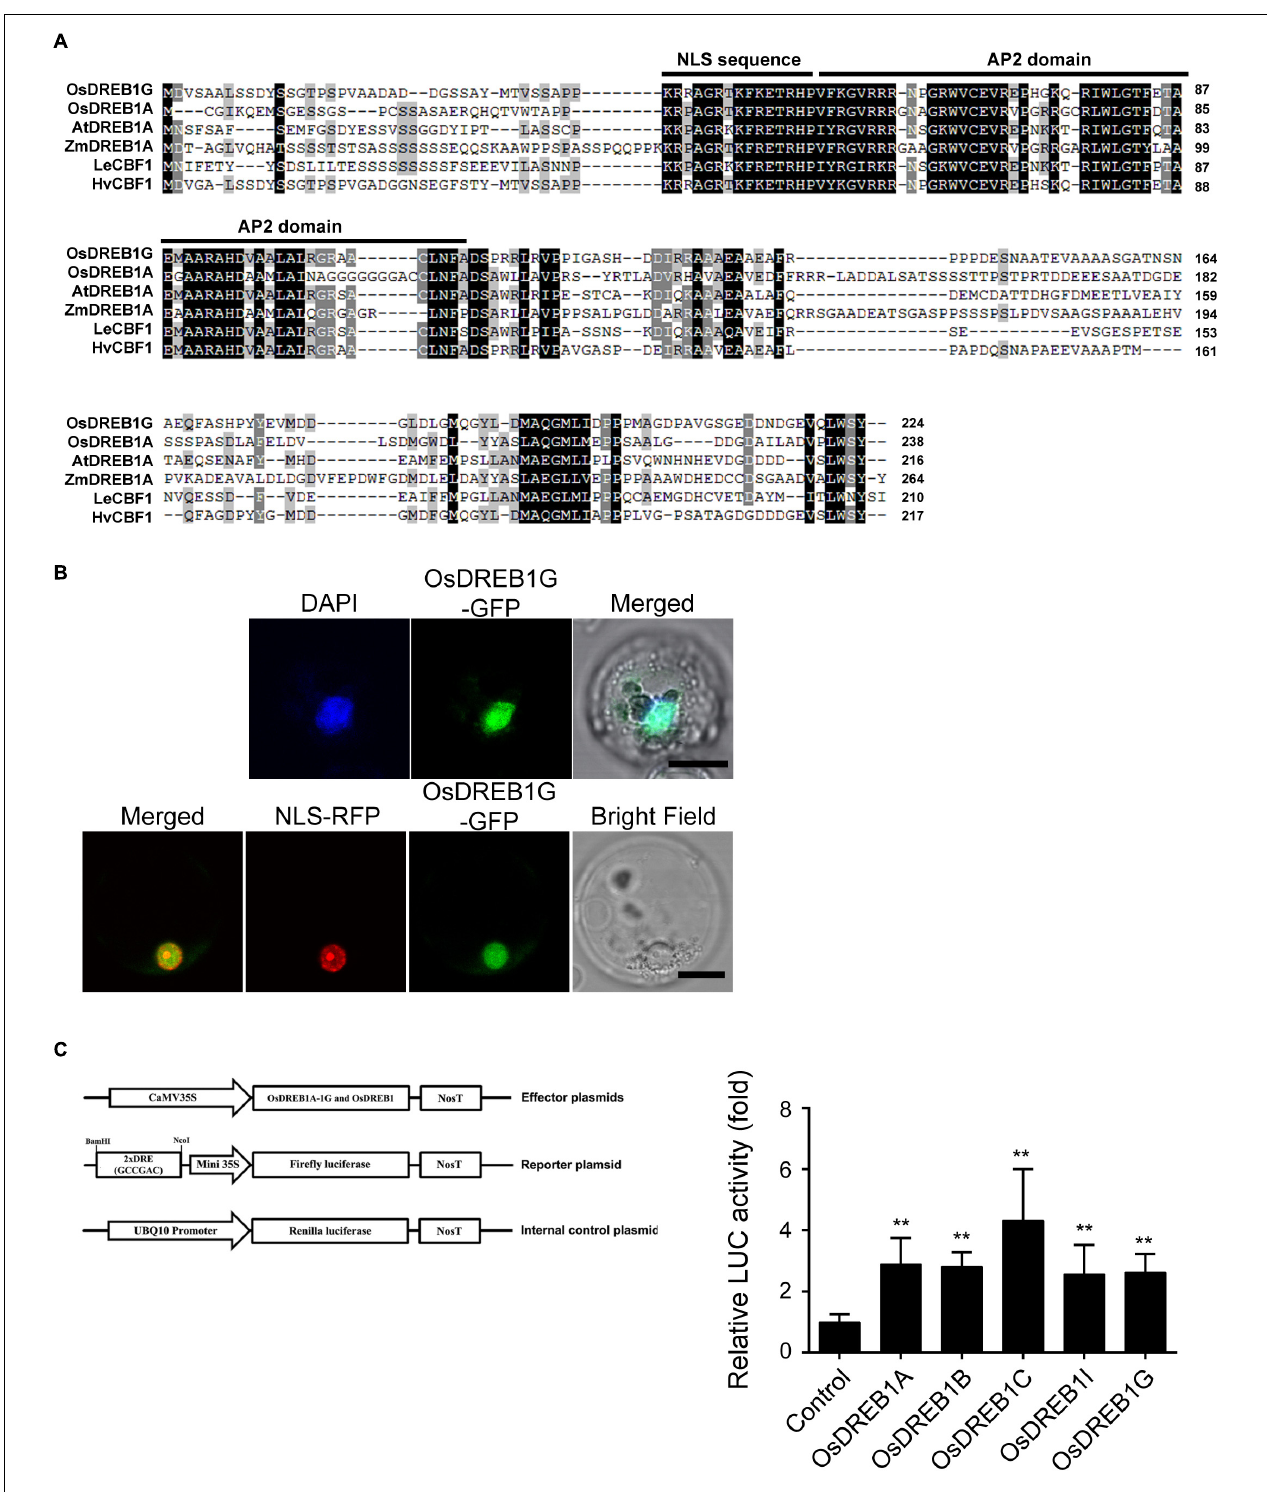
FIGURE 2 | OsDREB1G has typical characteristics of OsDREB1 proteins. (A) Multiple sequence alignment of OsDREB1G and homologous proteins (B) Subcellular localization of OsDREB1G-GFP fusion protein in rice protoplasts. The protoplasts were transformed with only OsDREB1G or NLS-RFP (nucleus marker) together and then for 24 h incubation at 28 ◦ C, the protoplasts were observed (lower panel) and after DAPI staining by laser scanning confocal microscope (upper panel). Scale bars are 10 mm. (C) Transactivation analyses of several OsDREB1s for the DRE element. Luciferase activity was measured using rice protoplasts transfected by each effectors and reporter. Error bars indicate standard errors. The experiments were performed with at least three biological repetitions. ∗∗ means P < 0.01.